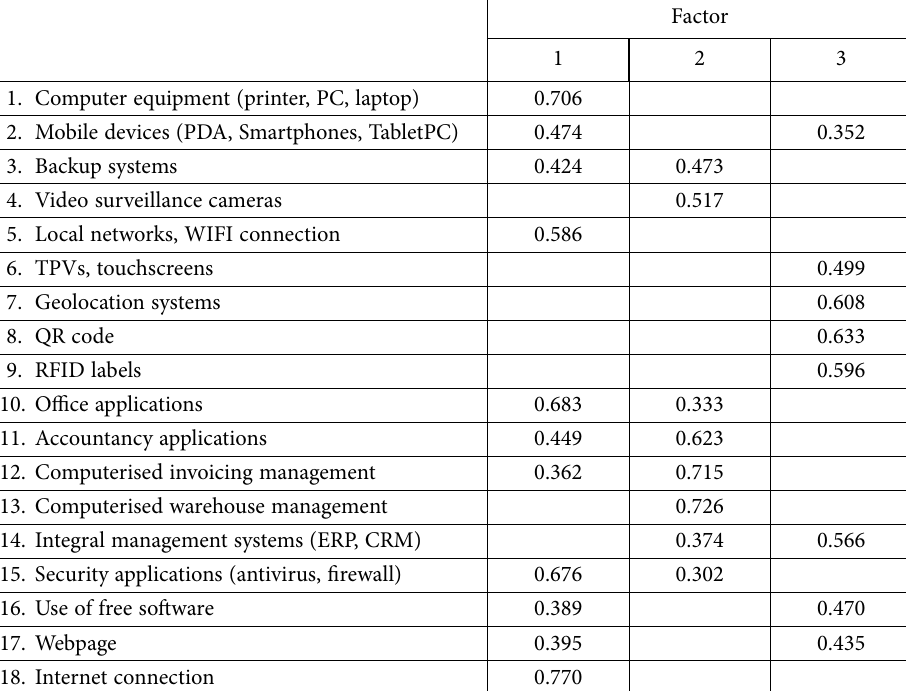
Table 3. Principal axis factoring: rotated factor matrix a (source: own